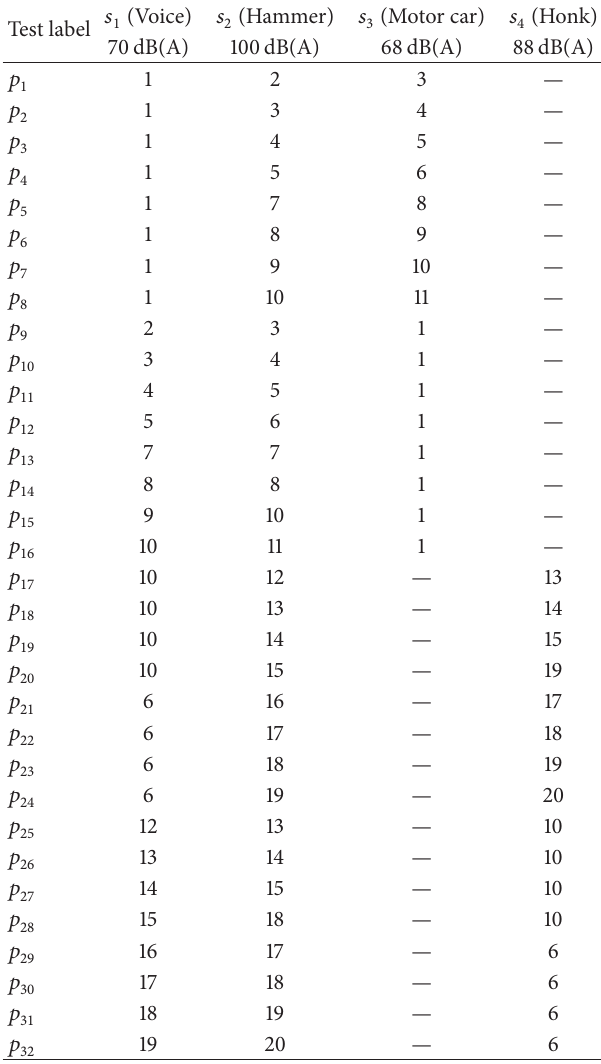
Table 1: Position reporting the source label for each test and the SPL of the